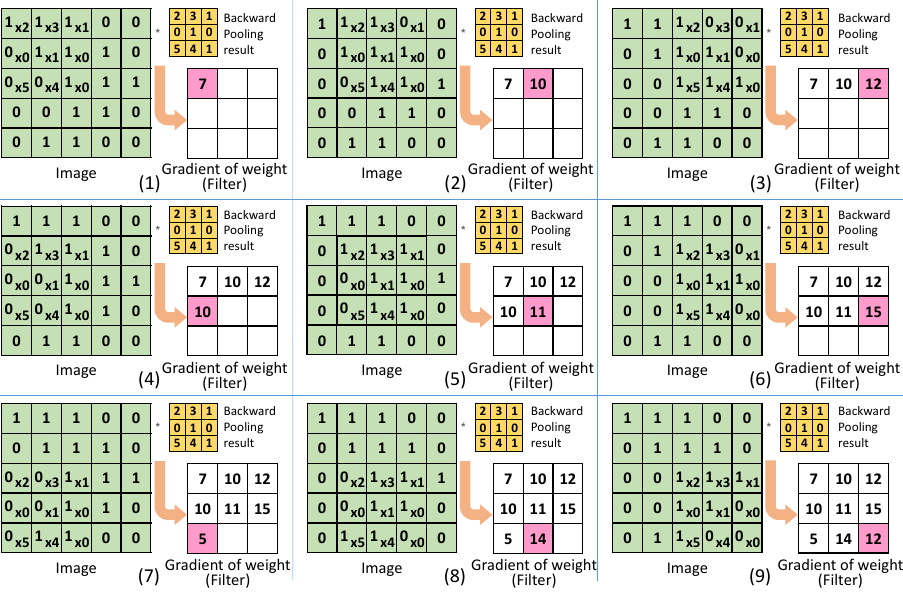
Figure 5. Operation of convolution layer in backpropagation.